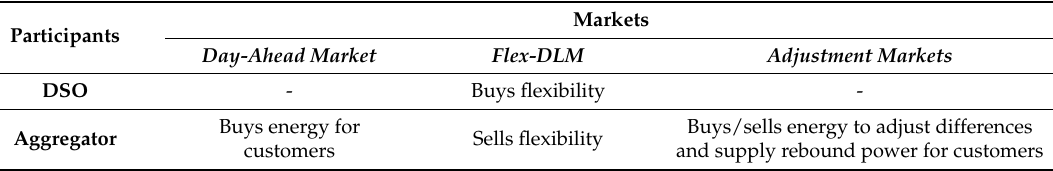
Table 4. Energy trading across